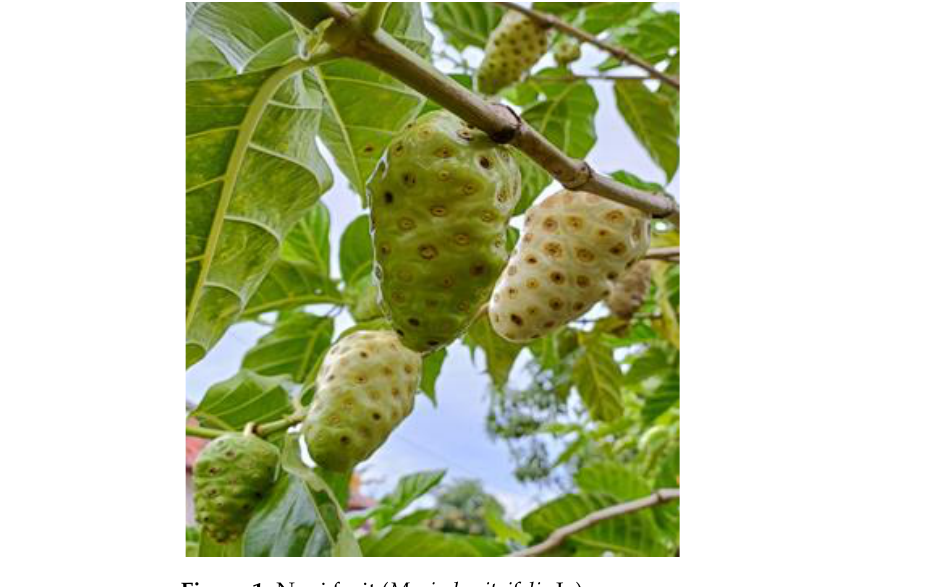
Figure 1. Noni fruit ( Morinda citrifolia